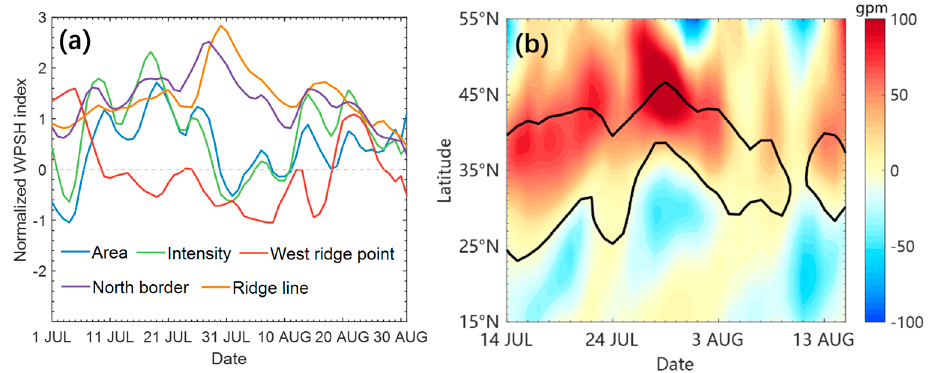
Figure 12. ( a ) Daily time series of normalized area (blue), intensity (green), west ridge point (red), north border (violet) and ridge line (orange) indices for WPSH. ( b ) Time-latitude evolution of the 500 hPa geopotential height anomalies averaged over the region from 115° to 140° E. The solid black line denotes the variation in the 5880 gpm isoline at 500